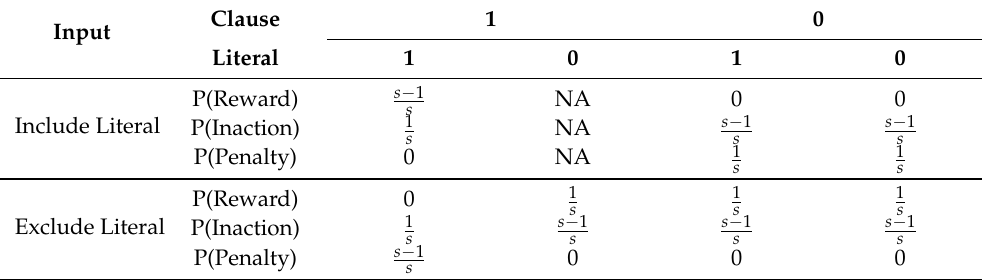
Table 1. The Type I Feedback [16].